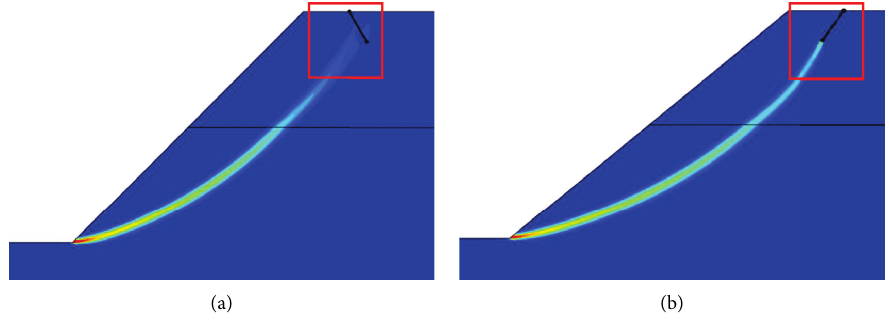
Figure 18: Failure surface at different crack angles. (a) α � 60 ° . (b) α � 120 °